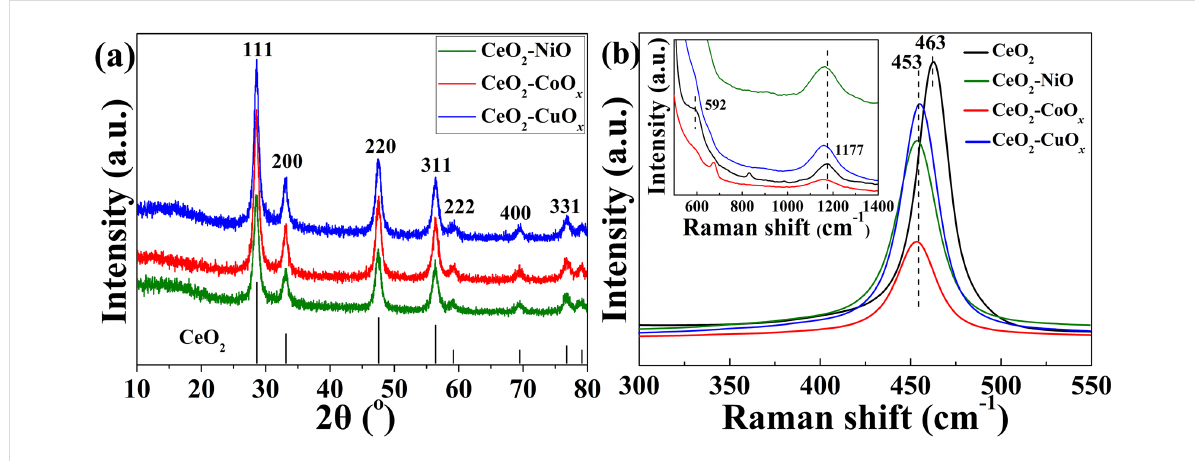
Figure 6: XRD patterns (a) and Raman spectra (b) of the as-synthesized CeO 2 –MO x composite yolk–shell nanospheres.